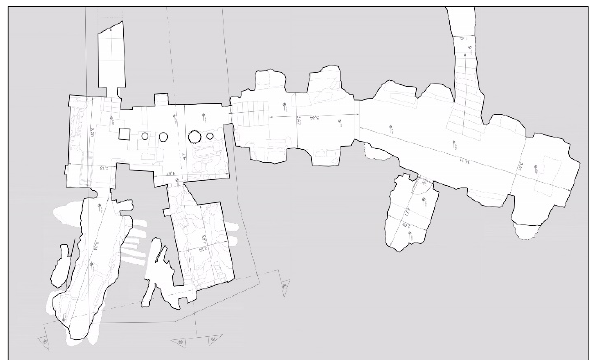
Figure 2. Planimetric survey of the entire complex of the catacombs.